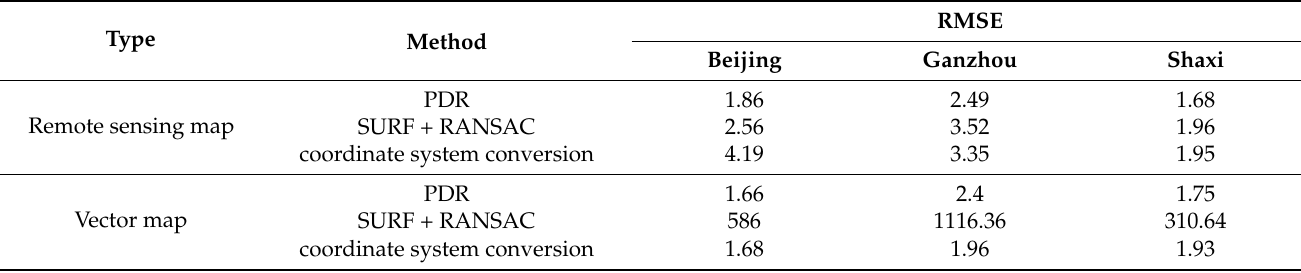
Table 7. RMSE of registration for three methods in six